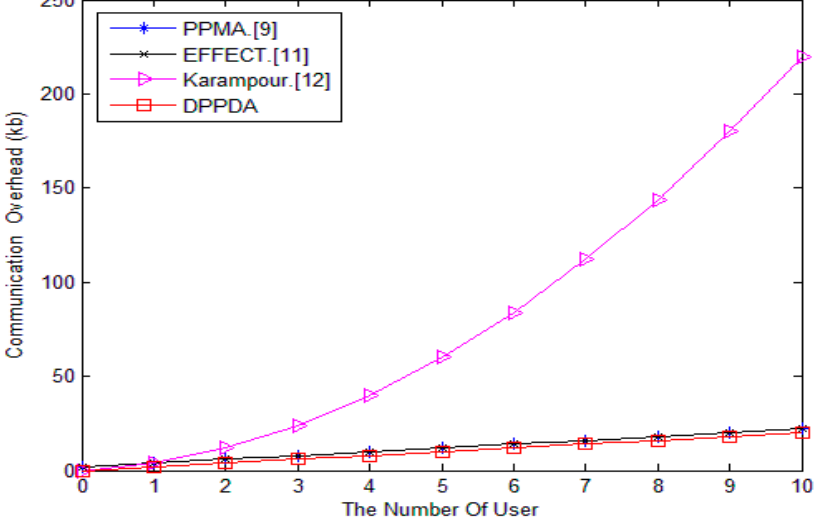
Figure 5. Comparison of communication cost.